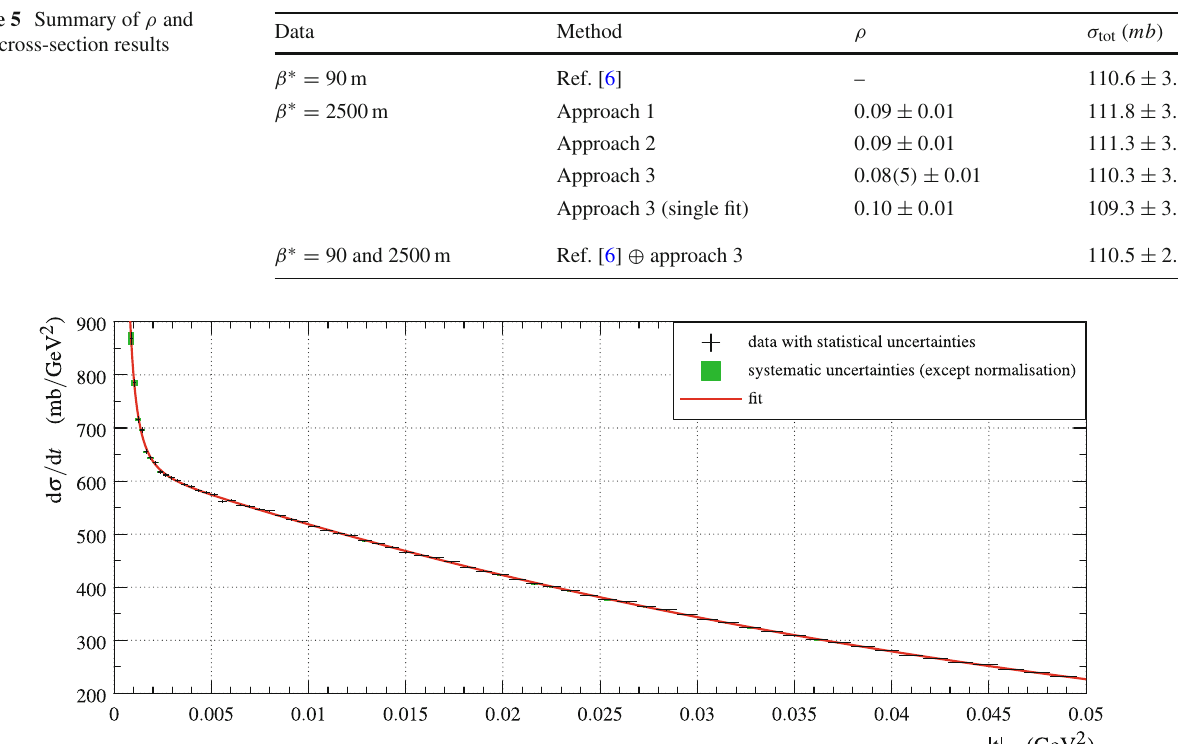
Table 5 Summary of ρ and